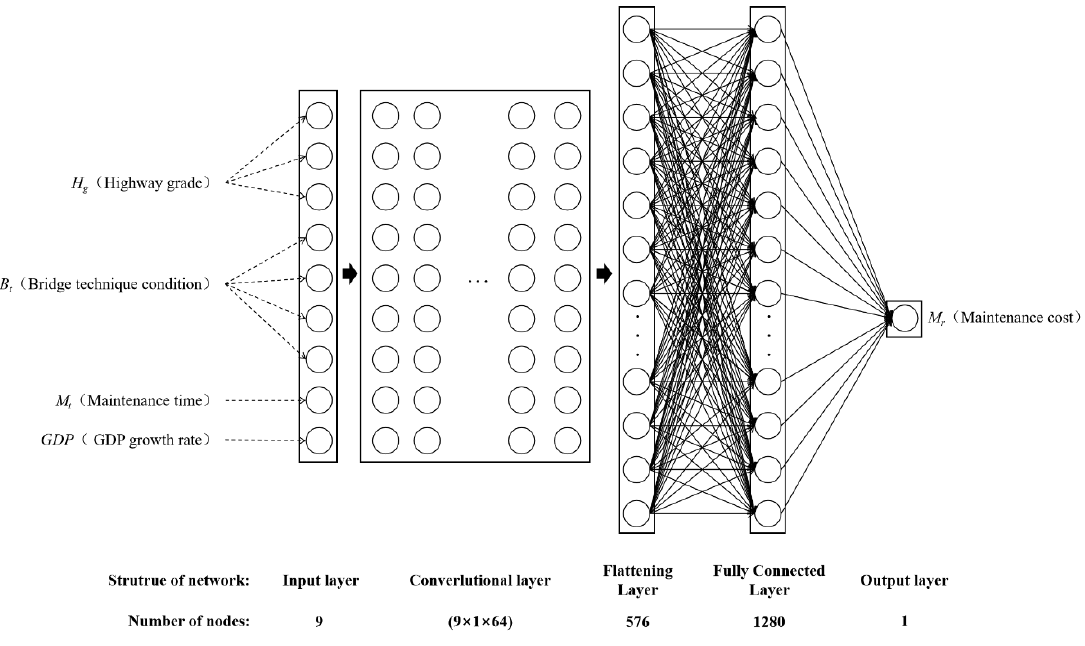
Figure 12. Topology of the CNN prediction